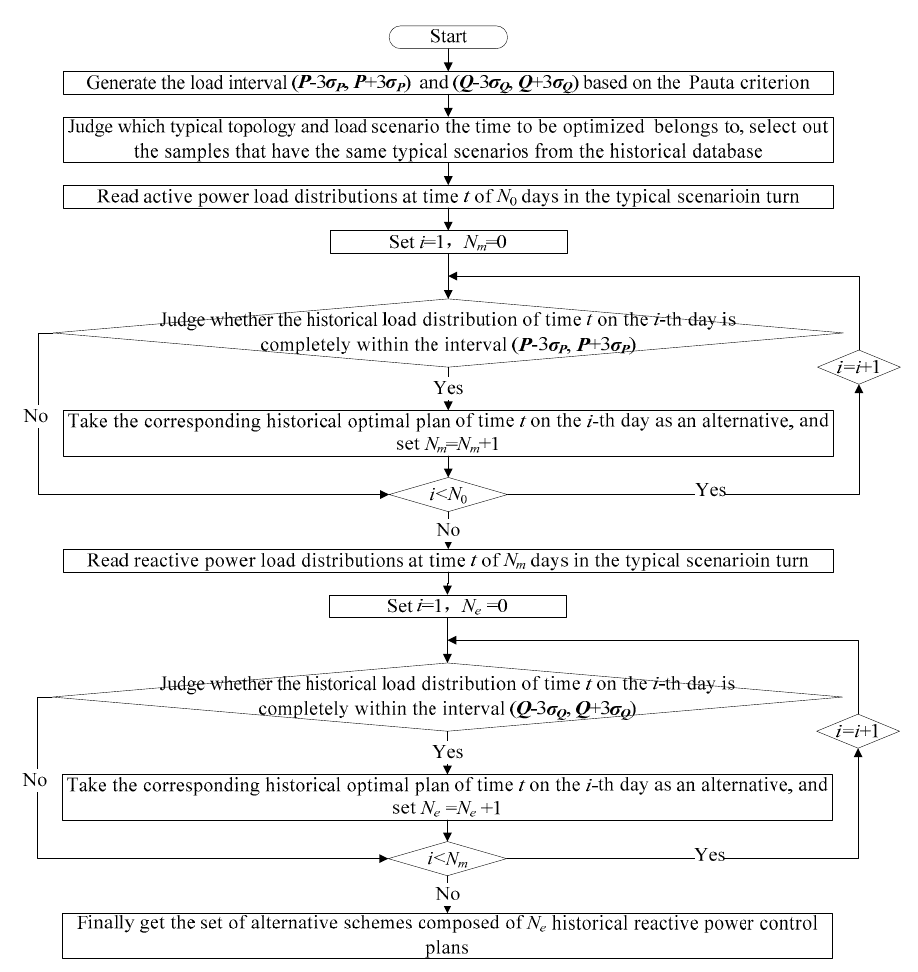
Figure 3. Flow chart of load distribution matching.